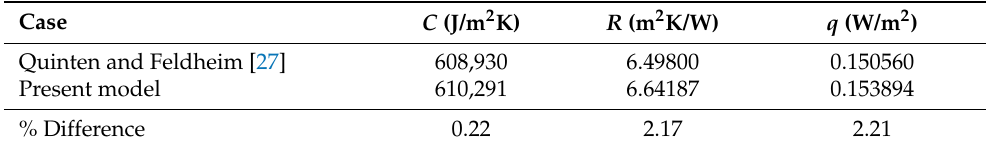
Table 3. The published and predicted heat capacity ( C ), thermal resistance ( R ), and heat flux ( q ) for the thermal bridge of the intermediate floors.